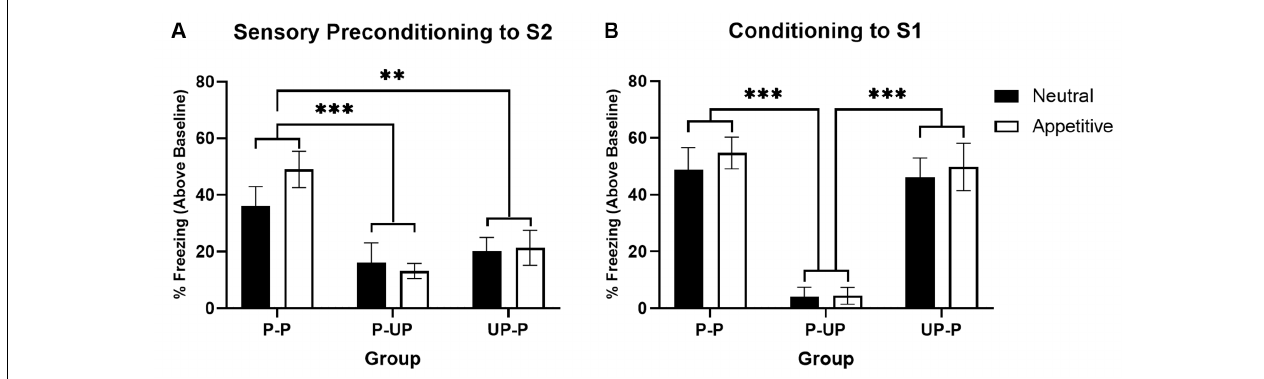
FIGURE 2 | Sensory preconditioning in a neutral vs. appetitive context. Panel (A) shows the average per cent time spent freezing in response to S2 (stimulus—baseline) on the test of sensory preconditioning when groups were trained in a neutral context vs. appetitive context. Groups P-P show significantly more freezing than either Groups P-UP or UP-P, irrespective of context valence. Panel (B) shows the average per cent time spent freezing to S1 (stimulus—baseline) on the test of first-order conditioning when groups were trained in a neutral context vs. appetitive context. Groups P-UP show significantly less freezing than either Groups P-P or UP-P, irrespective of context valence. Black bars indicate groups trained in a neutral context, while white bars indicate groups trained in an appetitive context ( n = 8 for all groups). Groups P-P experienced paired S2-S1 and S1-US training; Groups P-UP experienced paired S2-S1 and unpaired S1 and US training; Groups UP-P experienced unpaired S2 and S1 and paired S1-US training. Error bars represent ± SEM. Significant comparisons are indicated by: ∗∗ where p < 0.01; ∗∗∗ where p < 0.001.